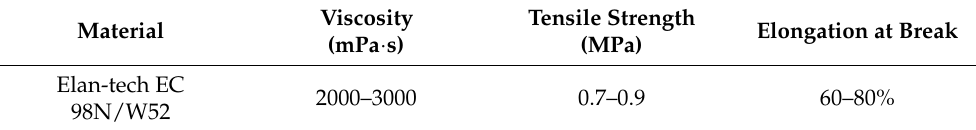
Table 2. Physical and mechanical properties of the epoxy resin (from manufacturer).